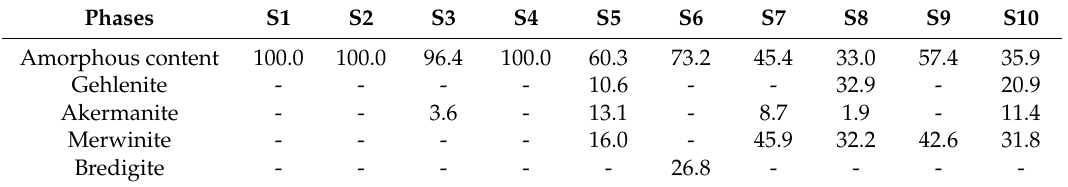
Table 6. Phase contents of air quenched slags determined by XRD-Rietveld analysis (wt.%). Phases Amorphous